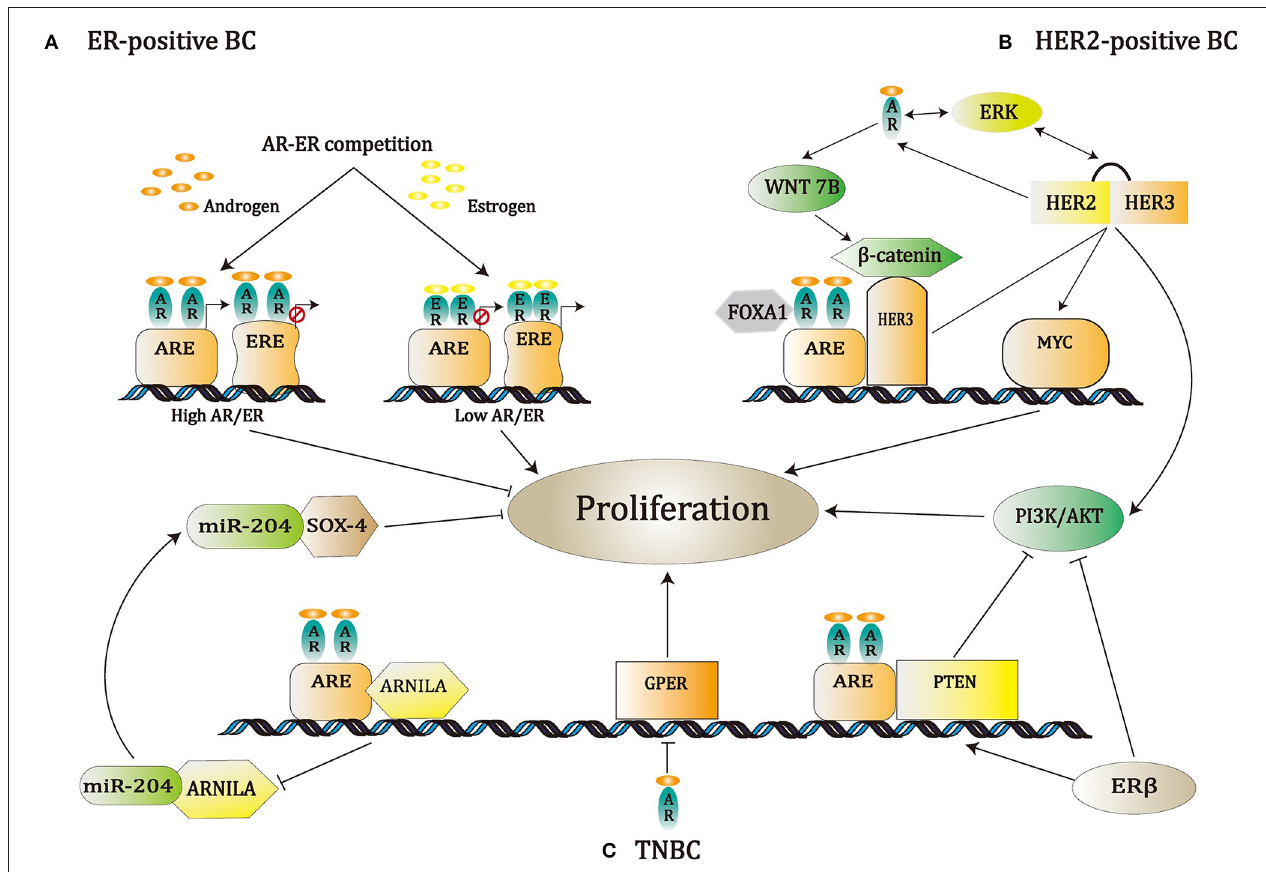
FIGURE 1 | A schematic of known pathways regulated by AR in various breast cancer subtypes. (A) In ER-positive BC, it has been found that AR influenced the ER pathway by competition with ER for attaching to the modulatory regions of ER genes; meanwhile, the AR/ER expression ratio makes a critical difference in the regulation of BC cell proliferation. (B) In HER2-positive BC, the Wnt/ β -catenin signaling pathway is up-regulated by the AR. AR/ β -catenin complex, together with FOXA1, induces HER3 gene transcription. Next, HER3 and HER2 create a heterodimer, thereby stimulating the PI3K/AKT pathway and MYC gene expression. Additionally, ERK, AR, and HER2 take part in a positive feedback cycle. (C) In TNBC, the up-regulation of PTEN through AR or ER β represses PI3K action, which in turn reduces AR activity. Suppression of GPER by AR can also modulate cell behavior positively, while suppression of ARNILA results in negative